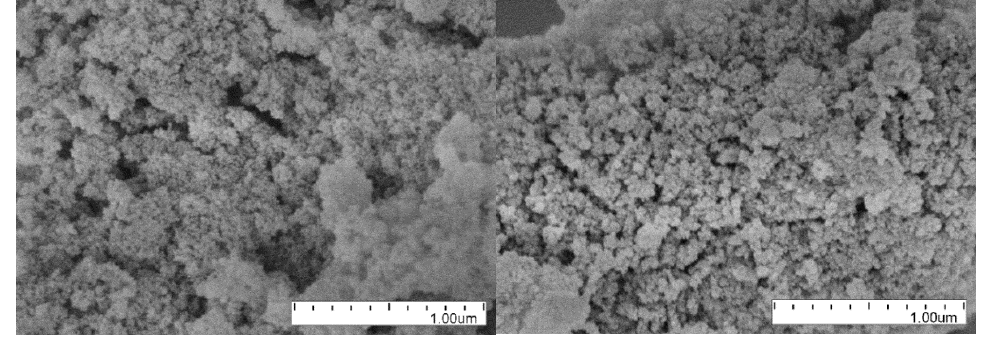
Figure 6. Examples of SEM images of DNDs ( on left ) and F-DNDs ( on right ).